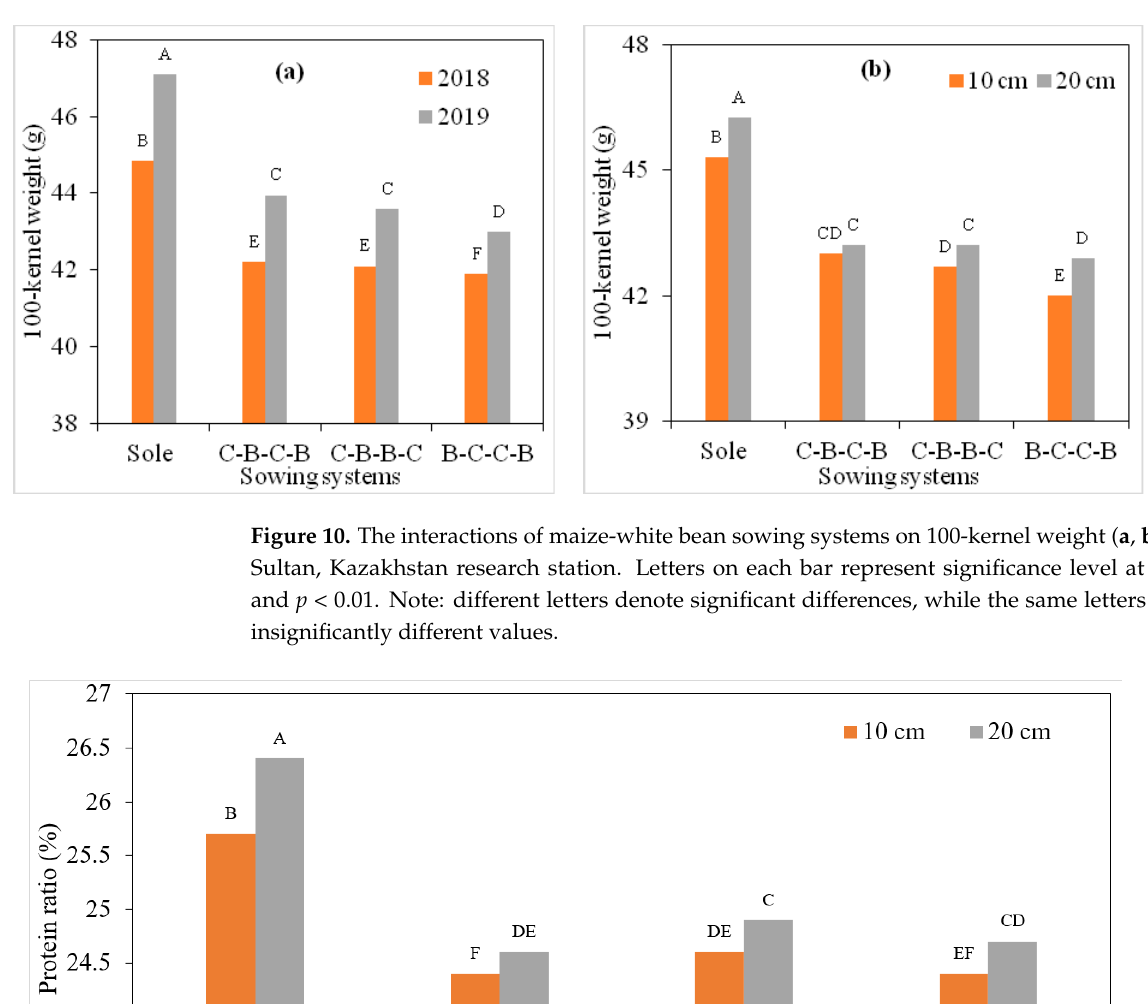
Figure 9. The interactions of maize–white bean sowing systems on protein ratio ( a , b ) at Nur Sultan, Kazakhstan research station. Letters on each bar represent significance level at p < 0.05 and p < 0.01. Note: different letters denote significant differences, while the same letters indicate insignificantly different values.